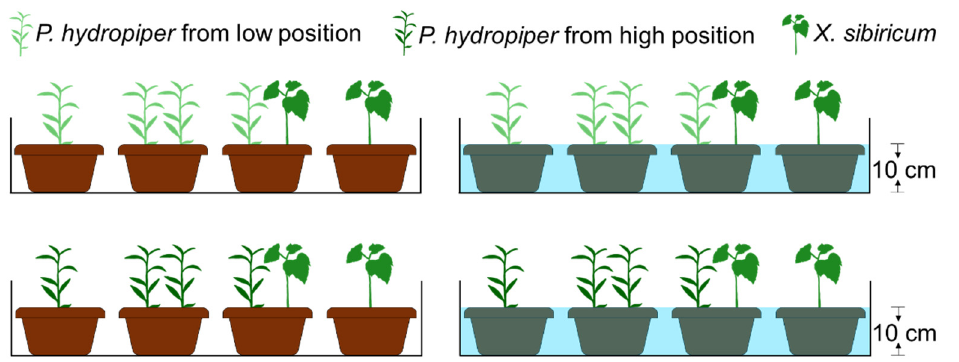
Figure 1. Schematic representation of the experimental design. The experiment included two water levels (i.e., control and flooding), three types of competition (i.e., without, intraspecific, and interspecific), and two positions (i.e., low and high) at the hydrofluctuation belt of the shoreline of the Three Gorges Reservoir. This schema was replicated six times for each of the three sites. In the experiment without competition, one plant of P. hydropiper or X. sibiricum was grown in the center of the pot; in the experiment with intraspecific competition, two P. hydropiper plants were grown together in one pot; in the experiment with interspecific competition, one plant of P. hydropiper and one plant of X. sibiricum were grown together in one pot.